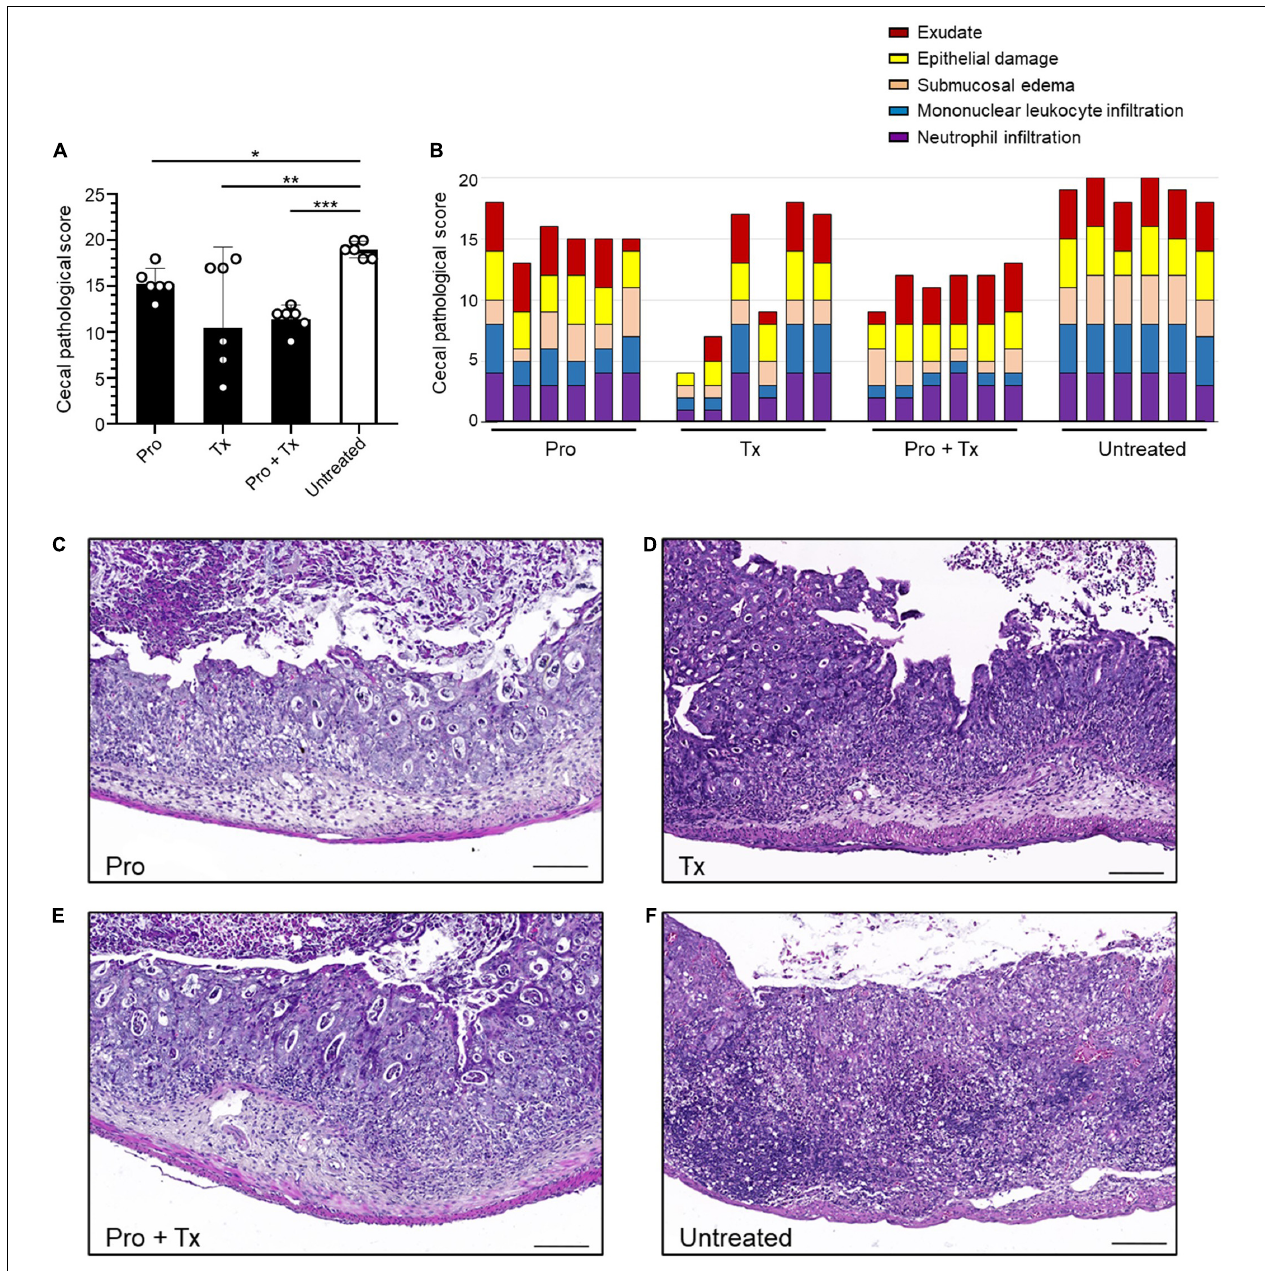
FIGURE 7 | Decreased cecal histopathological scores in STM-infected mice orally fed with L. reuteri KUB-AC5. At day 4 post infection, mouse ceca were sectioned and stained for hematoxylin and eosin to evaluate the severity of gut inflammation. Exudate, epithelial damage, submucosal edema, mononuclear leukocyte infiltration, and neutrophil infiltration were assessed. The graphs display total pathological score (A) and individual score (B) . The representative pictures of prophylactic (Pro), therapeutic (Tx), combined (Pro + Tx), and untreated (D) are shown in (C–F) , respectively. Bars represent geometric means. * P < 0.05, ** P < 0.01, and *** P < 0.001 compared to all other